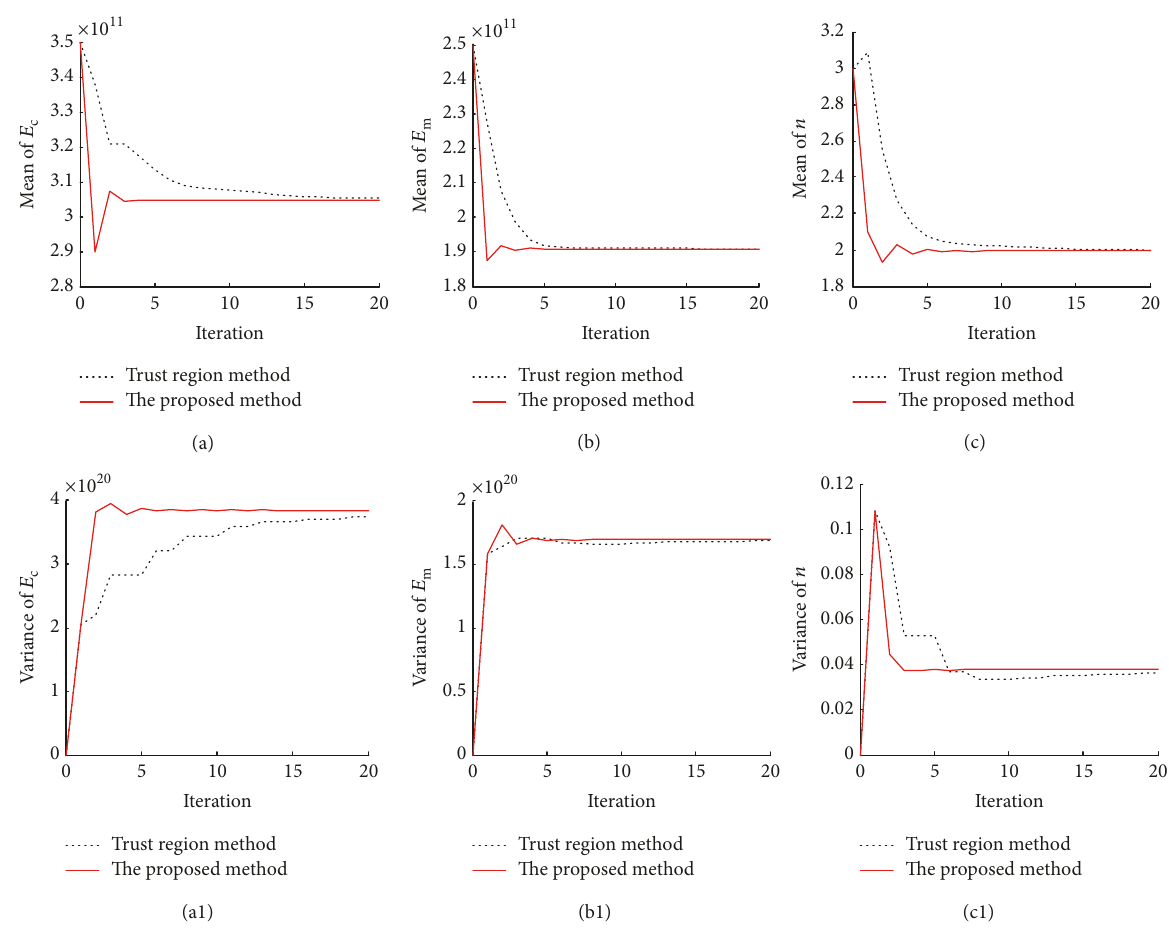
Figure 5: Iterative process of means and variances of 𝐸 c , 𝐸 m , and 𝑛 for two methods ( 𝑇 = 600